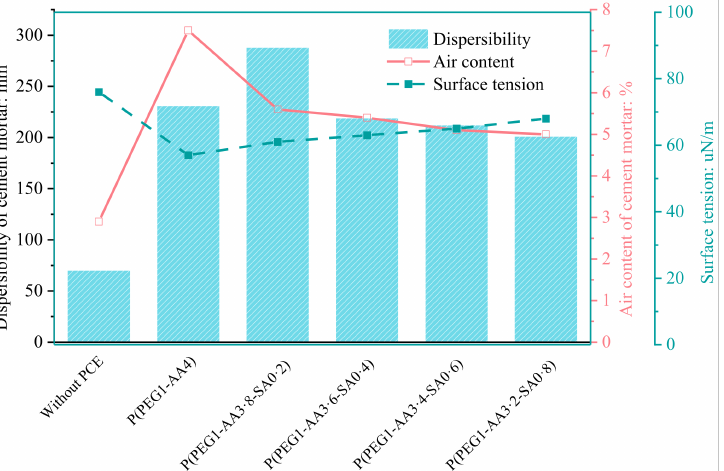
Figure 17. Effect of introducing sulfonic acid groups into PCEs on the air void of fresh cement mortar.